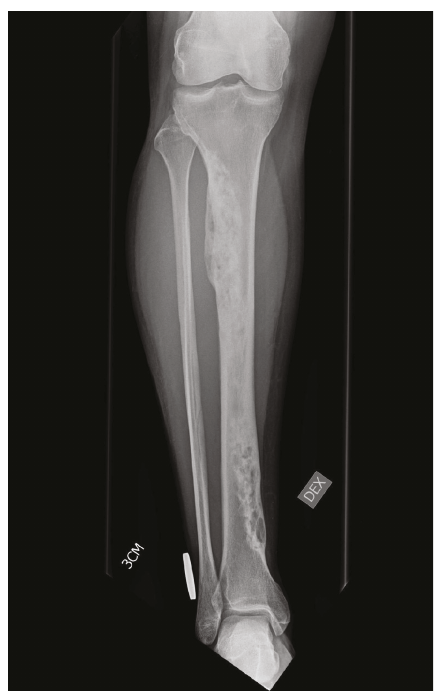
Figure 1: Preoperative X-ray from a right tibia. A plain X-ray from a right tibia with an intraosseal tumor that extended from 4cm below the knee joint proximally to about 4cm from the ankle joint